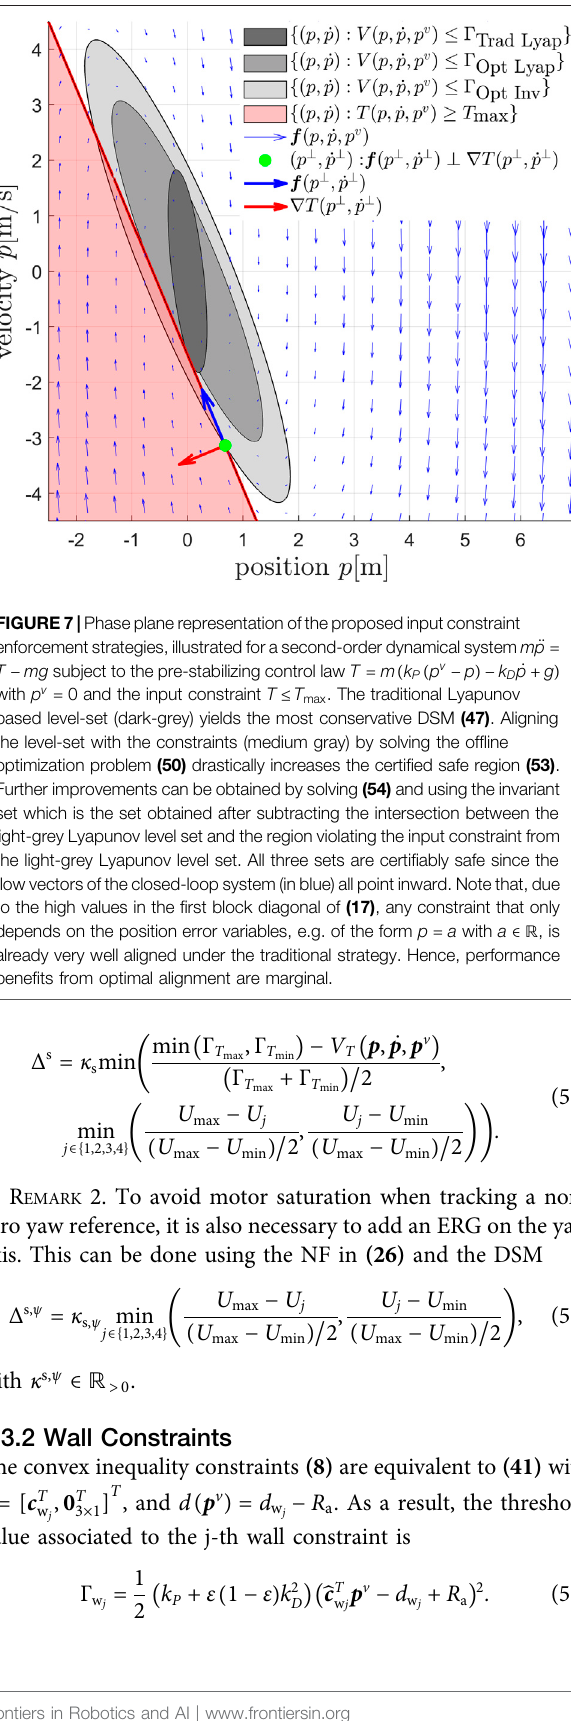
Frontiers in Robotics and AI |